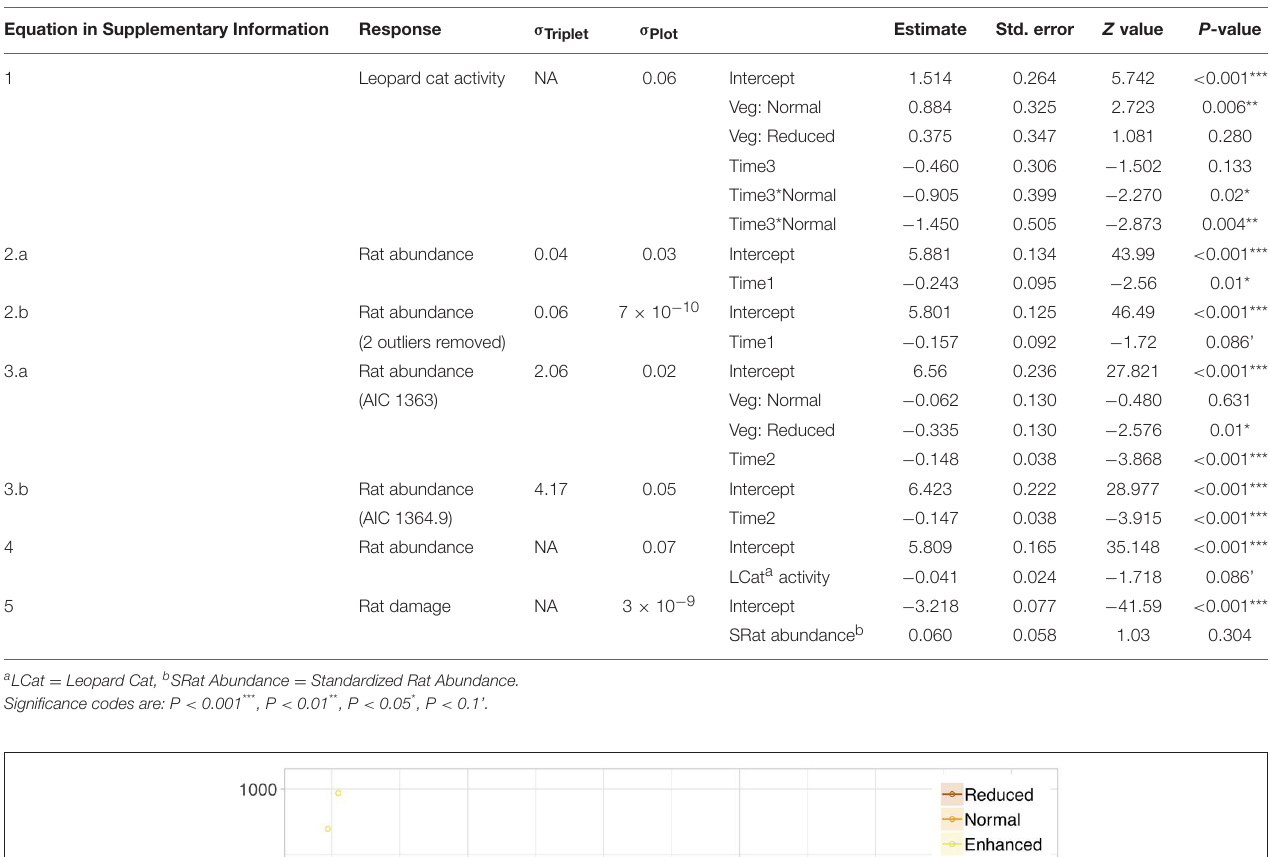
findings are in line with other studies that have demonstrated a low persistence of forest species in oil palm plantations (e.g., Wearn et al., 2017). Of the native species recorded, Leopard Cats